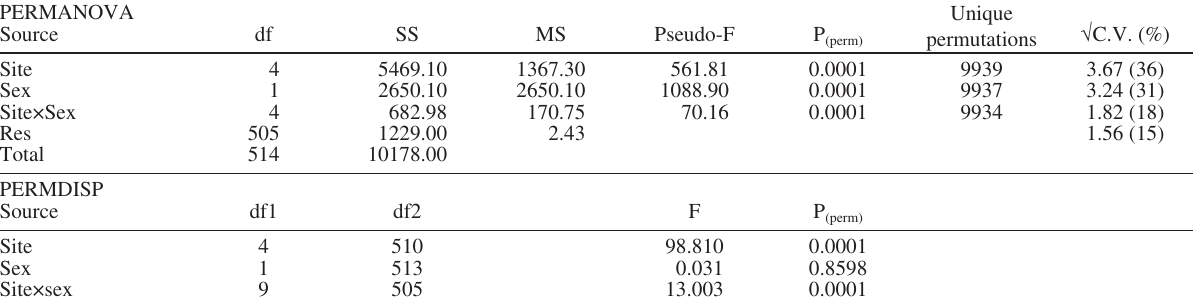
Table 2. – Two-factor multivariate PERMANOVA and PERMDISP results based on Euclidean distance measures estimated since standard- ized morphometric variables of Aratus pisonii . √ C.V.: Square root of estimates of components of variation. PERMANOVA